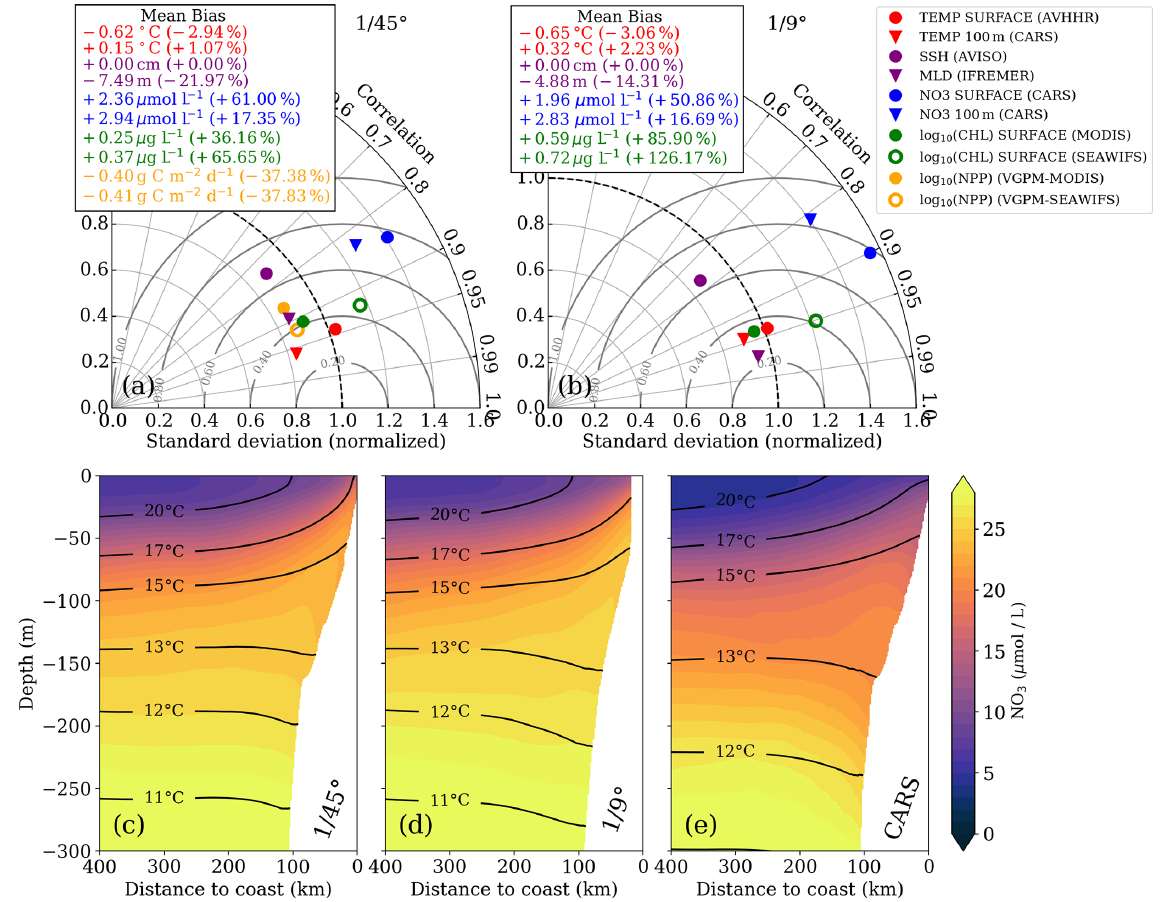
Figure 2. Taylor diagrams for (a) 1 / 45 ◦ and (b) 1 / 9 ◦ simulations, respectively. The statistics were computed from temporally averaged 2-year-mean fields (see Fig. S1) and therefore represent their spatial variability. Due to the strongly skewed distributions of chlorophyll a and PP, these variables were logarithmized prior to computing correlation and standard deviation to approximate normally distributed variables, while the mean bias was calculated using the original values. Gray concentric circles centered around unity-normalized standard deviation and correlation indicate the normalized root mean square error (NRMSE). The analysis for the 1 / 9 ◦ simulation was restricted to the extent of the 1 / 45 ◦ domain to facilitate direct comparison. Primary-production rates were not saved for the 1 / 9 ◦ simulation and could therefore not be evaluated. (c–e) Along-shore-averaged sections of mean nitrate concentrations with temperature contours superimposed for the (c) 1 / 45 ◦ simulation, (d) 1 / 9 ◦ simulation, and (e) CARS climatology. The CARS climatology was interpolated onto the 1 / 45 ◦ model grid before computing the along-shore